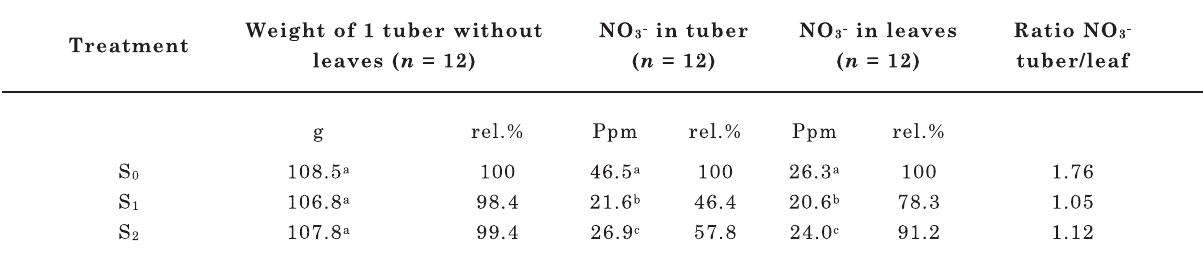
Table 3. Yield results of kohlrabi experiment